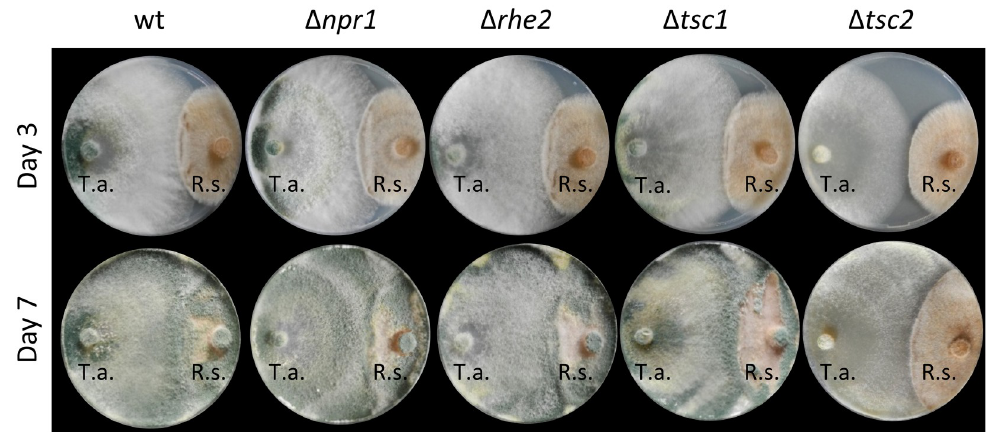
Fig 5. Confrontation assays for assessing the mycoparasitic activity of T . atroviride Δ npr1 , Δ rhe2 , Δ tsc1 and Δ tsc2 mutants and the wild type. Fungi were inoculated on opposite sides of a PDA plate (left side: T . atroviride ; right side: R . solani ) and grown at 25˚C for 7 days. Pictures were taken after 3 and 7